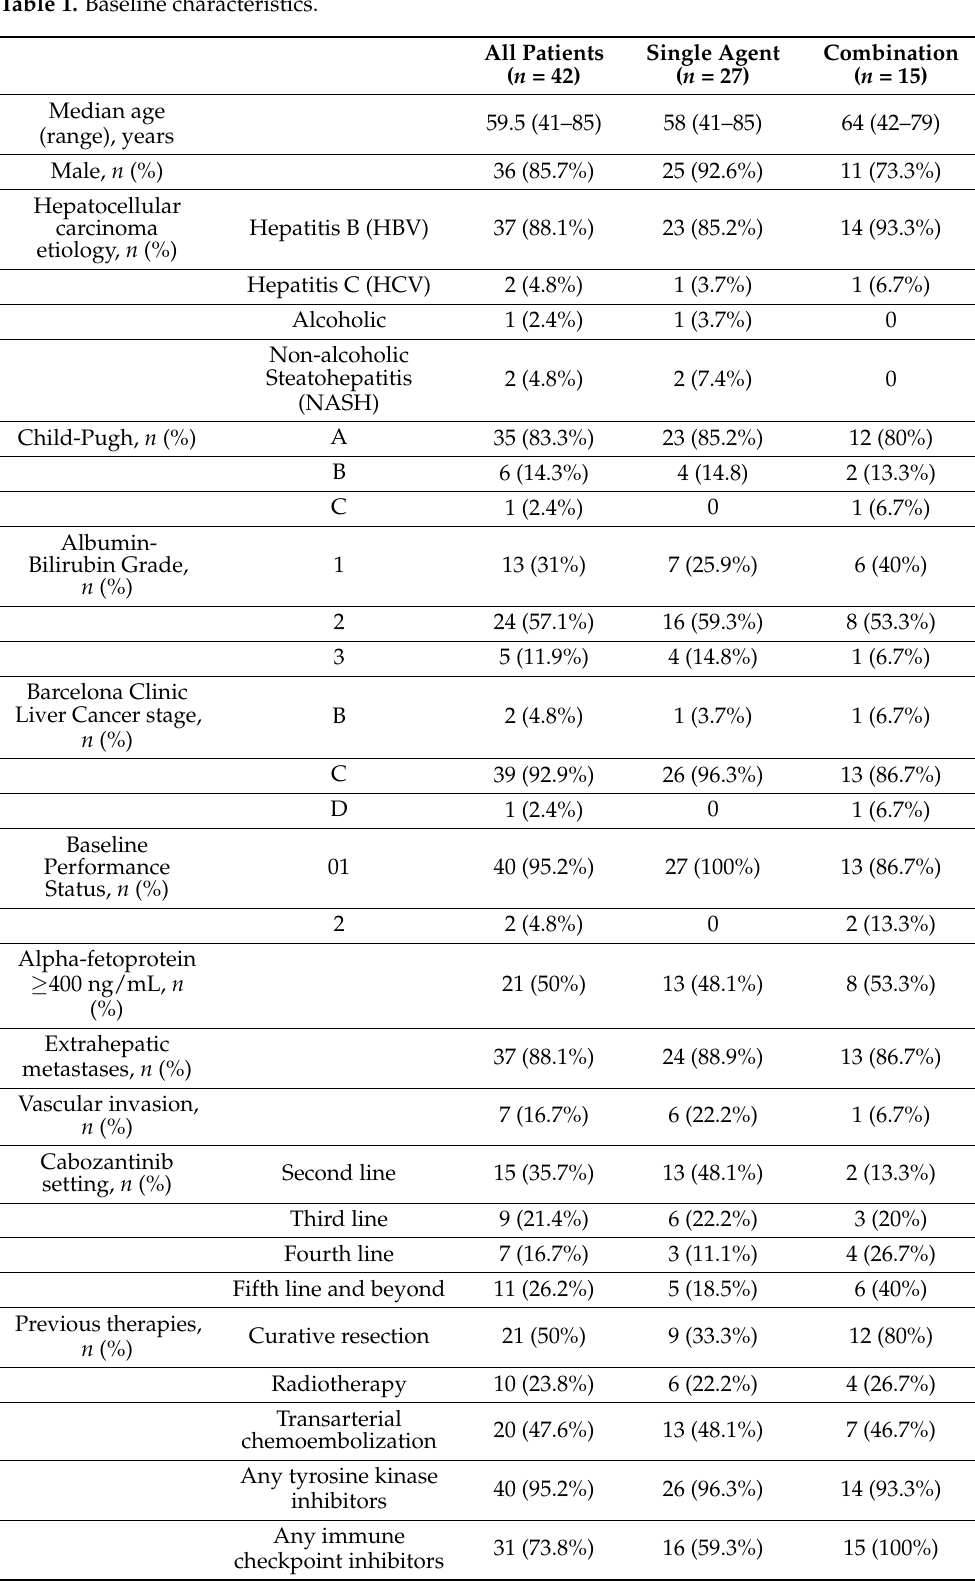
Table 1. Baseline